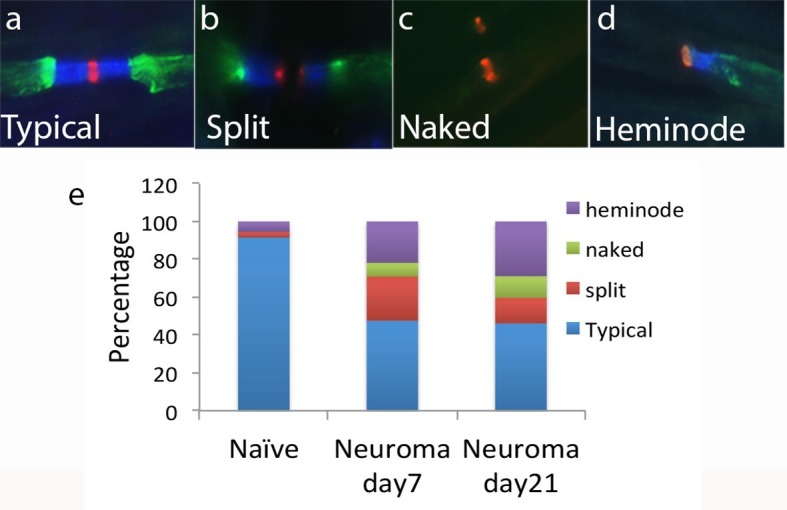
Nav channel expression.Representative sections of longitudinal nerves immunostained with Kv1.2 in green, a panNav antibody in red (to identify the node), and caspr in blue (to identify the paranode) from neuroma day 21. (a) A typical pattern of Nav expression localized at the node of Ranvier and flanked by caspr staining is shown. The altered forms of Nav channel accumulations seen in the injured nerve included (b) split nodes: These were nodes that had two distinct Nav channels accumulations, separated by a gap in the Nav channels staining within the same fibre and with each Nav channels accumulation flanked on one side with caspr staining, or (c) naked nodes: those Nav channel accumulations that lacked an association with caspr (d) heminodes: nodes where the caspr staining was located on only one side of a contiguous Nav channel accumulation. (e) Quantification of different types of sodium cluster accumulation in the naïve state and after nerve injury is shown.DOI:
http://dx.doi.org/10.7554/eLife.12661.00510.7554/eLife.12661.006Figure 2—source data 1.Source data for Figure 2.